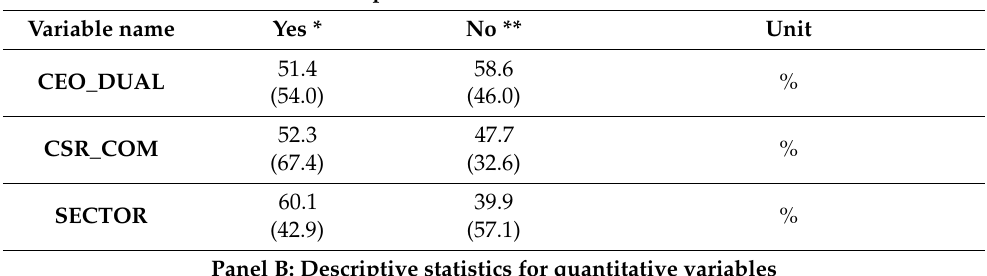
Table 3. Descriptive statistics. Panel A: Descriptive statistics of dichotomous